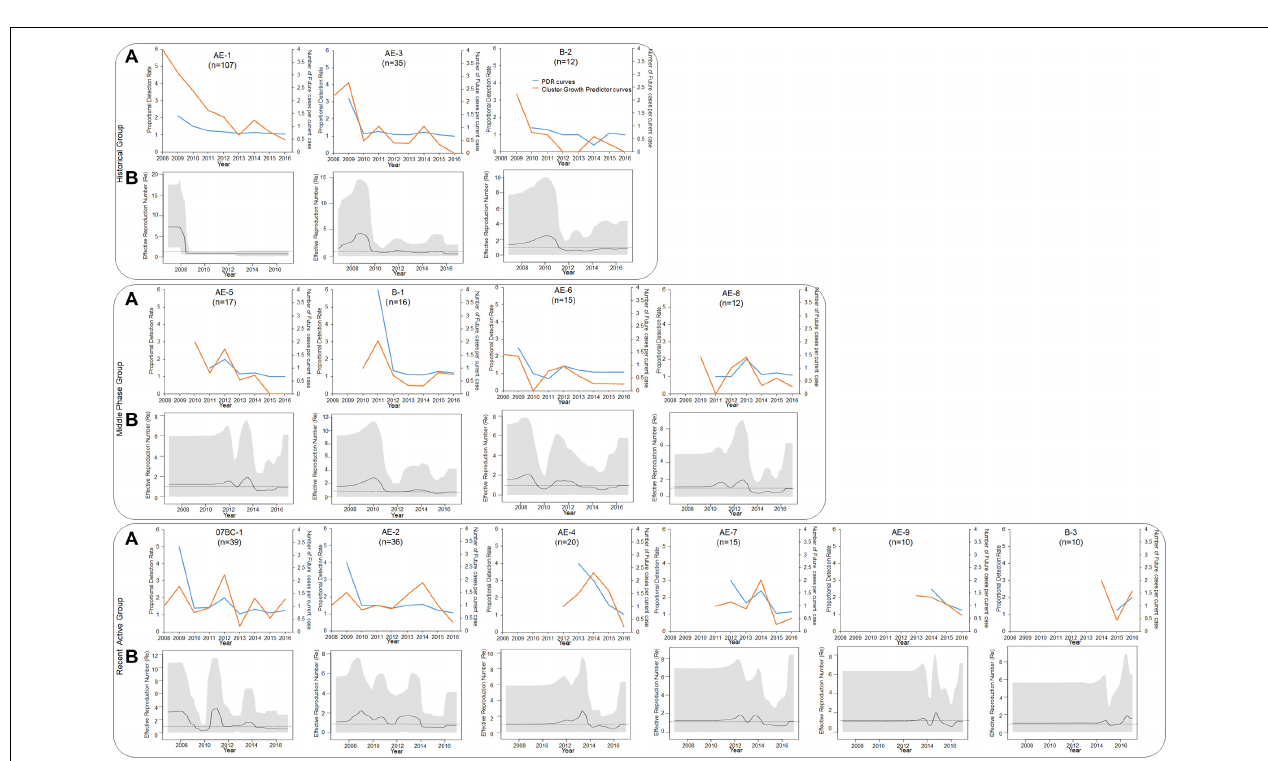
FIGURE 4 | PDR trends, cluster growth predictor trends, and R e of 13 large clusters ( ≥ 10 cases). (A) PDR trends (blue line), cluster growth predictor trends (orange line) (A) , and R e number (secondary infections per infected person) (B) during the period of 2008–2016. R e was inferred from the birth–death skyline plot. Thick solid lines represent the estimated mean, and 95% highest posterior density credible regions are shown as gray areas.